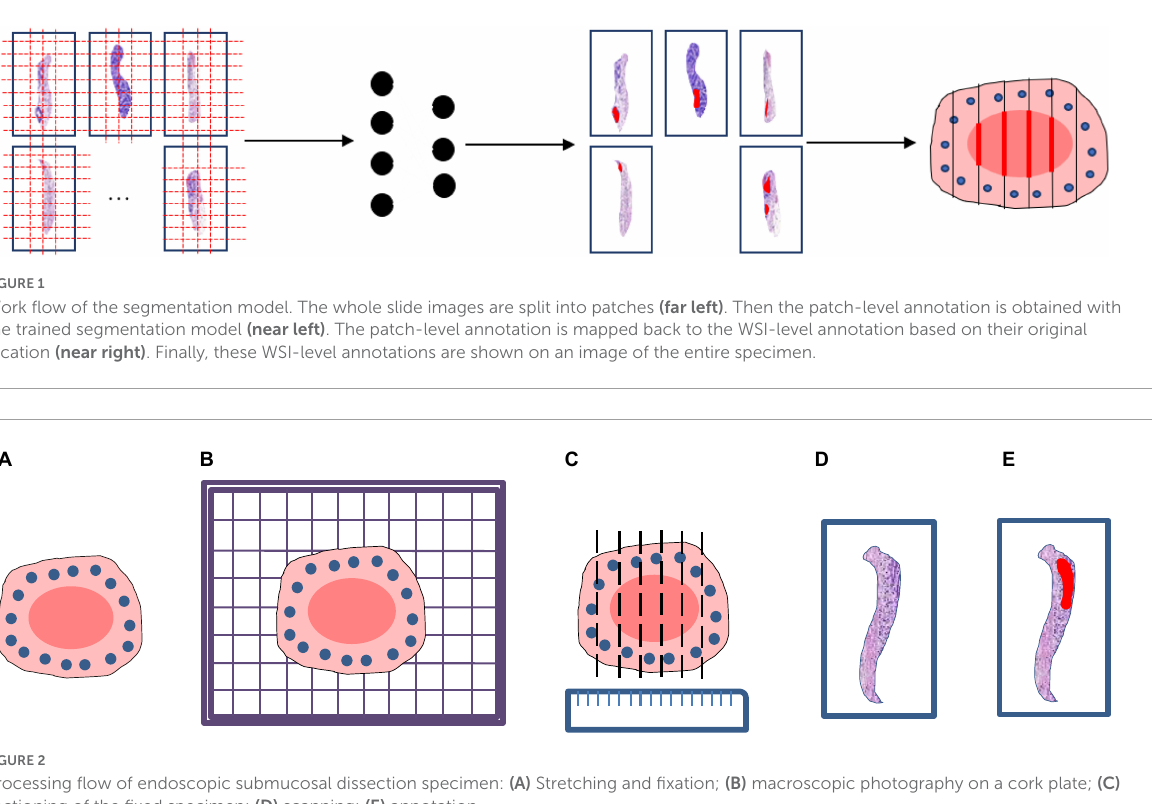
Table 1 . Random oversampling was adopted for overcome the unbalance between the lesion area and normal